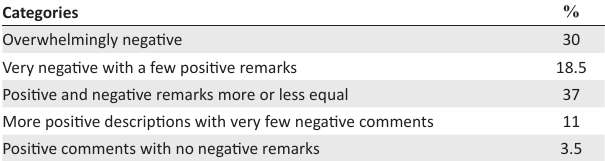
TABLE 3: Categorisation of participants based on their responses to their prior learning of mathematics. Categories % Overwhelmingly negative 30